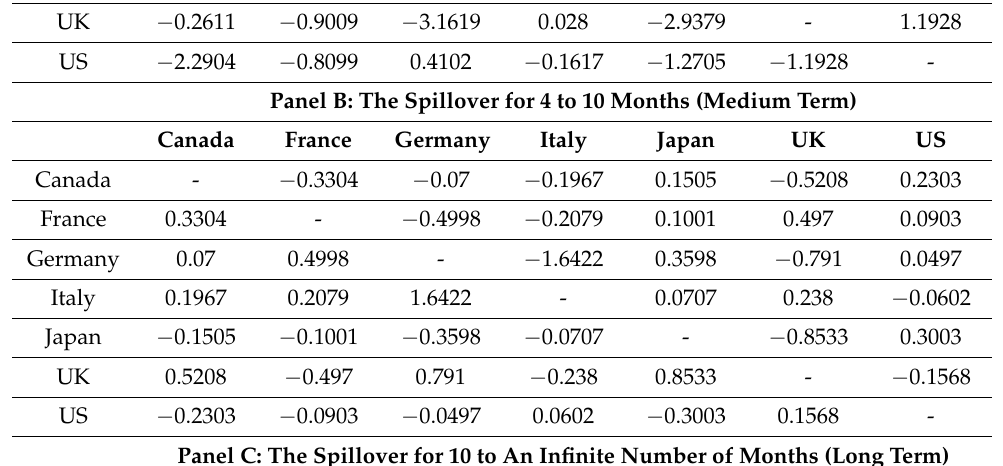
Panel C: The Spillover for 10 to An Infinite Number of Months (Long